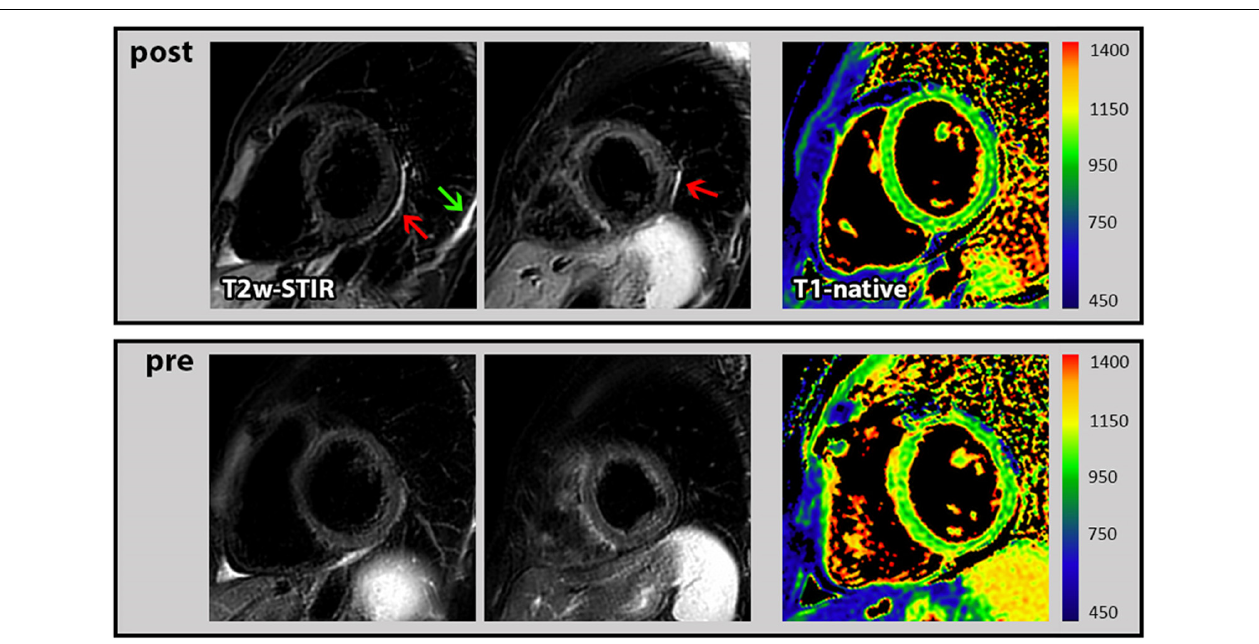
FIGURE 1 | Cardiac magnetic resonance (CMR) images of pericarditis. First row : T2-STIR-weighted short-axis images with the occurrence of pericardial hyperintensity as indication for edema/mild pericardial inflammation (red arrow) and a new pleural effusion (green arrow) following the 3rd COVID-19 vaccination. In addition, corresponding T1 mapping without signs of myocardial impairment. Second row : Corresponding images at baseline (prior to 3rd COVID-19 vaccination) from the same subject without any pathological